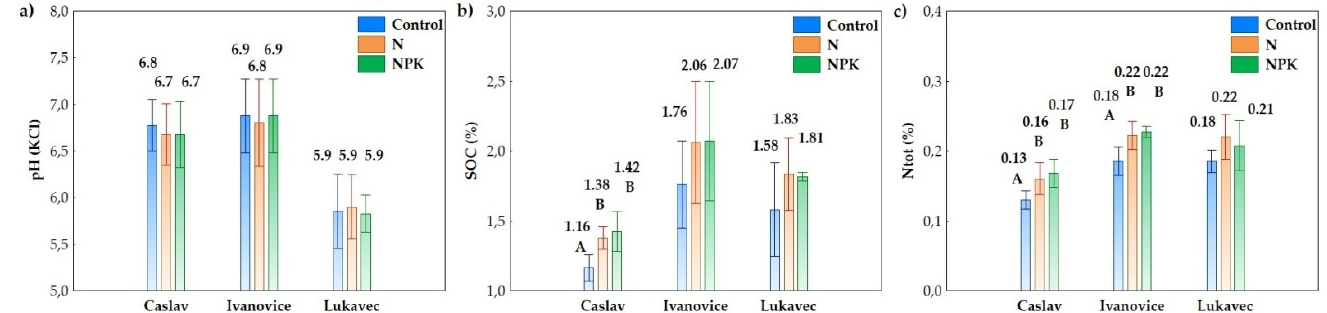
Figure 3. The effect of fertilizer treatments on soil ( a ) pH, ( b ) SOC (%), and ( c ) Ntot (%) in Caslav, Ivanovice and Lukavec (2013–2016). Mean values followed by the same letter are not statistically significantly different ( p < 0.05). No letter means that no difference was recorded in the locality.